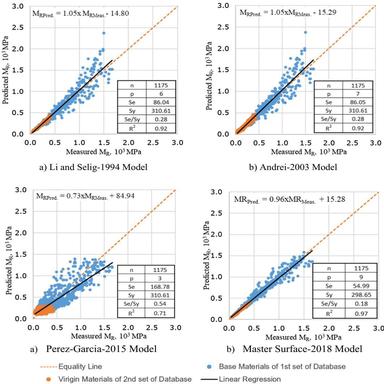
Predicted Values Vs. Measured MR for Granular Base Materials a) Li And Selig-1994 Model, b) Andrei-2003 Model, And c) Perez-Garcia-2015 Model d) Proposed Master Surface-2018 Model.